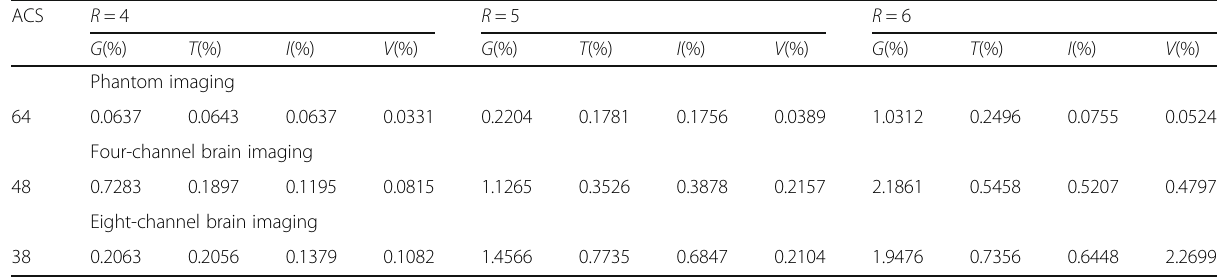
Table 1 Quantitative evaluation by using NMSE measure is compared among reconstructed images of the conventional GRAPPA, Tikhonov regularization, IRLS, and the proposed AV-GRAPPA, which are denoted as “ G , ” “ T , ” “ I , ” and “ V ” in the table, respectively. “ R ” represents the outer reduction factor, and the numbers of ACS lines are presented in the first column of the table. In addition, all reconstructions are implemented with the same sampling pattern. The proposed AV-GRAPPA generally has better performance